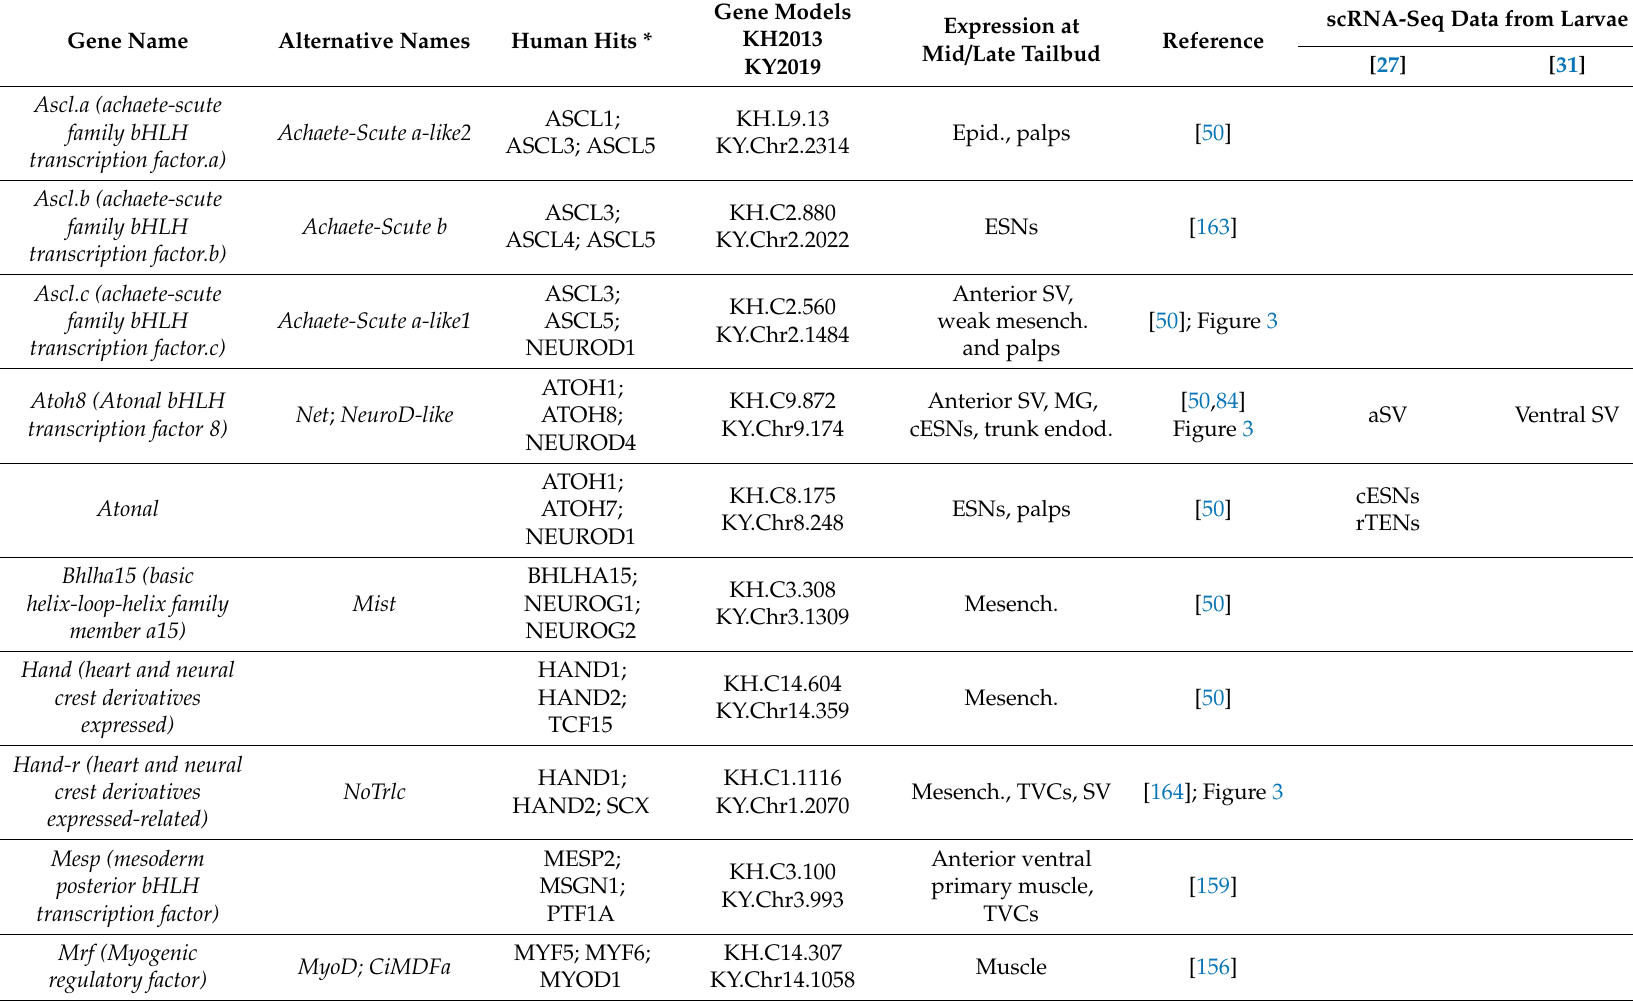
Table 1. Genes encoding transcription factors of the bHLH family in the ascidian Ciona robusta